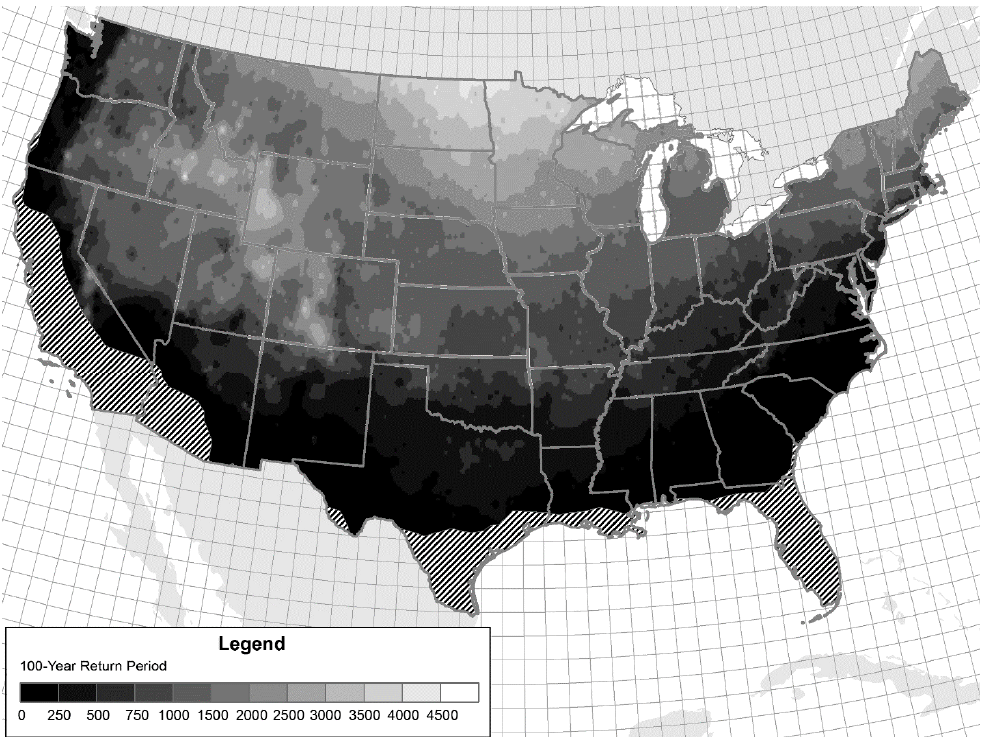
Figure 8. Freezing severity of winter and frost depth [20]. (Excerpt reprinted with permission).